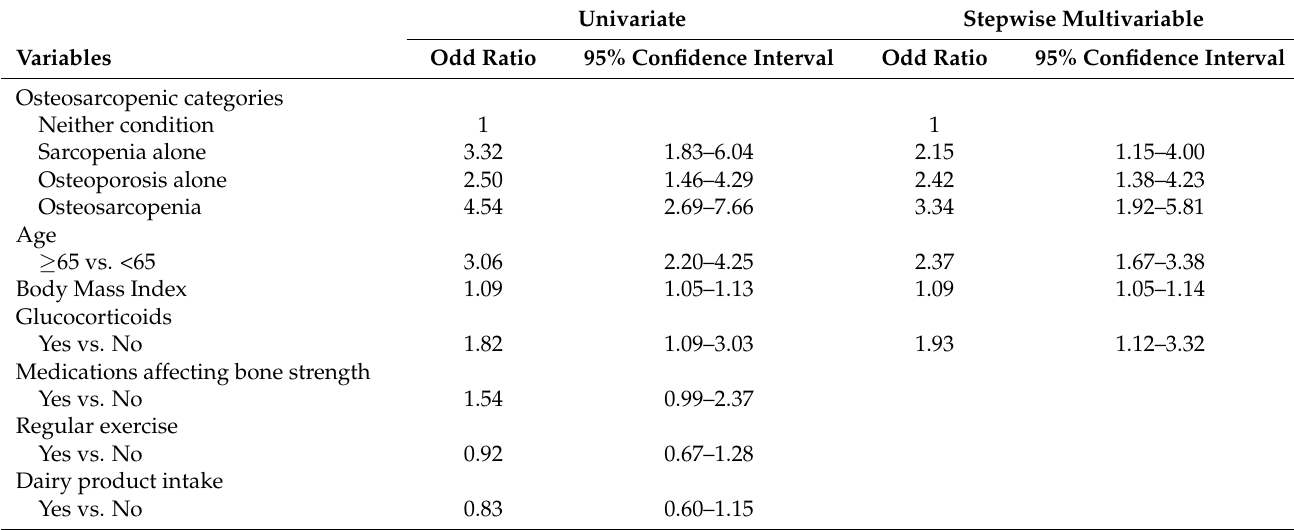
Table 2. Odds ratios for fragility fractures according to osteosarcopenic categories, in which the “osteo” component was defined T-score ≤ − 2.5 SD.